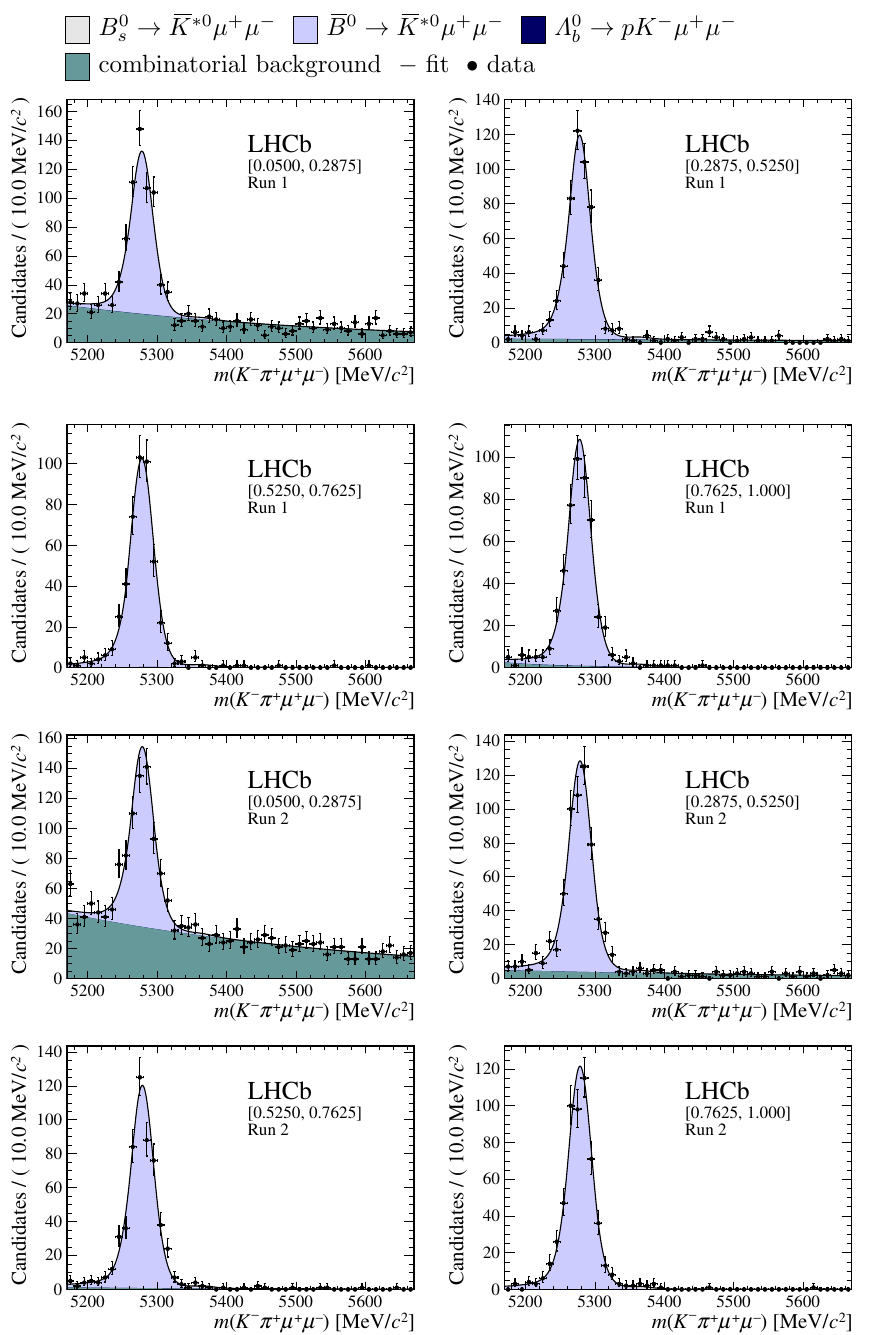
Figure 5 . Distribution of reconstructed K (cid:0) (cid:25) + (cid:22) + (cid:22) (cid:0) invariant mass of candidates outside of the J= and (2 S ) mass regions in (top four (cid:12)gures) the Run 1 and (bottom four (cid:12)gures) Run 2 data sets. The candidates are divided into four independent bins of increasing neural network response per data taking